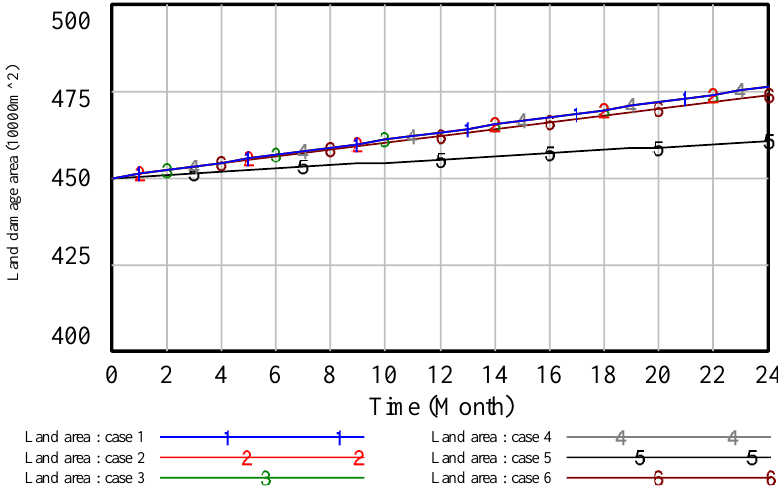
Figure 12. The simulation result of land damage area.